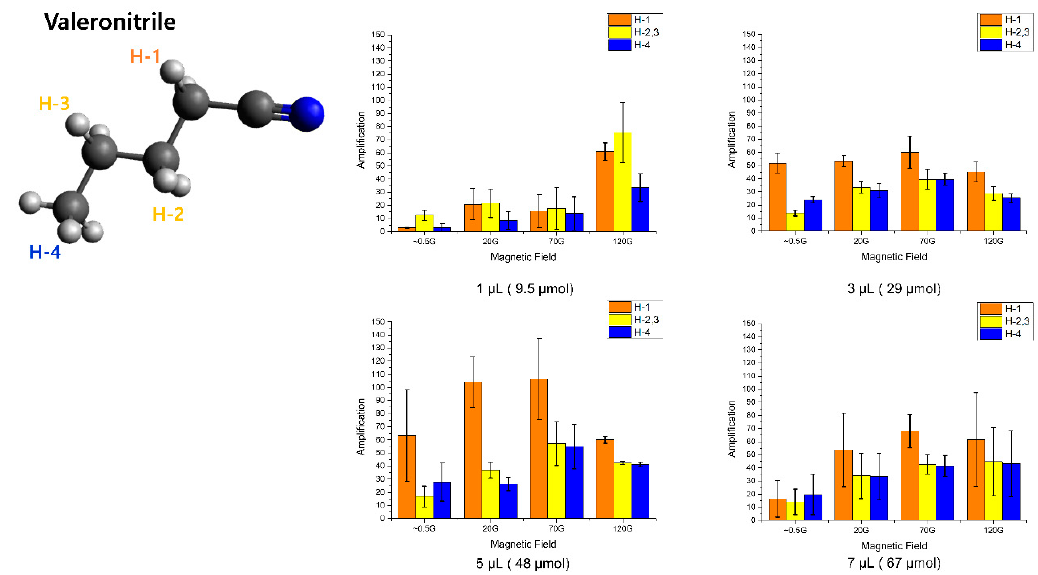
Figure 6. Amplification factors according to the different magnetic fields for the different amounts of valeronitrile in solvent (MeOH- d 4 ).